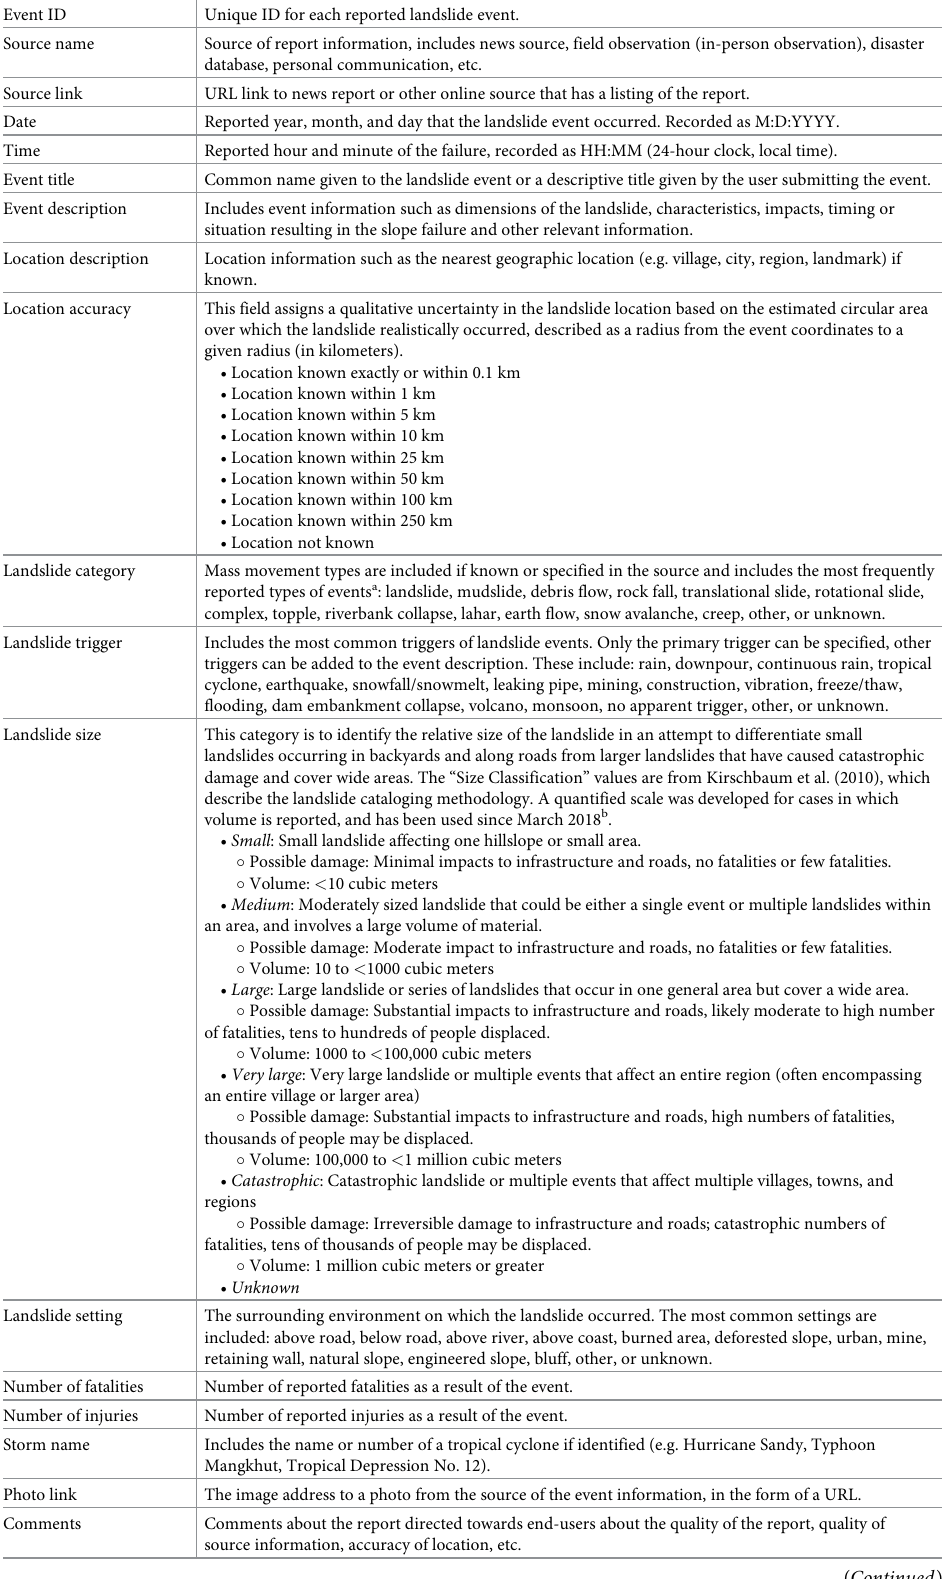
Table 2. Summary of fields included in the Cooperative Open Online Landslide Repository